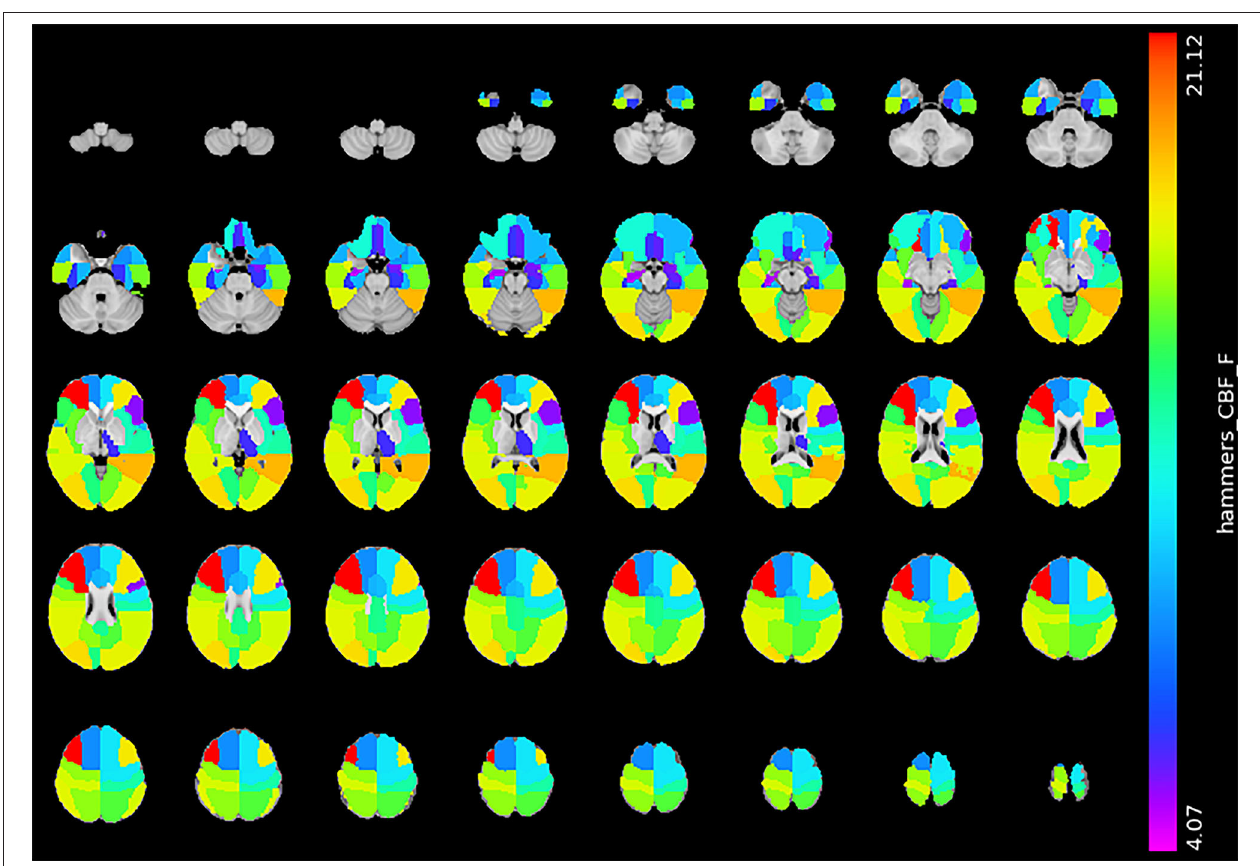
FIGURE 4 | Significant difference in CBF between the mild BG-PVS group and the severe BG-PVS group. The severe BG-PVS group shows a significantly lower CBF in the cortex and left thalamus ( P FDR < 0.05, corrected for age, sex, scanner and regional GMV). The F-score bar is shown on the right. The left part of the figure represents the right side of the individual. CBF, gray matter cerebral blood flow; BG-PVS, basal ganglia perivascular spaces; GMV, gray matter